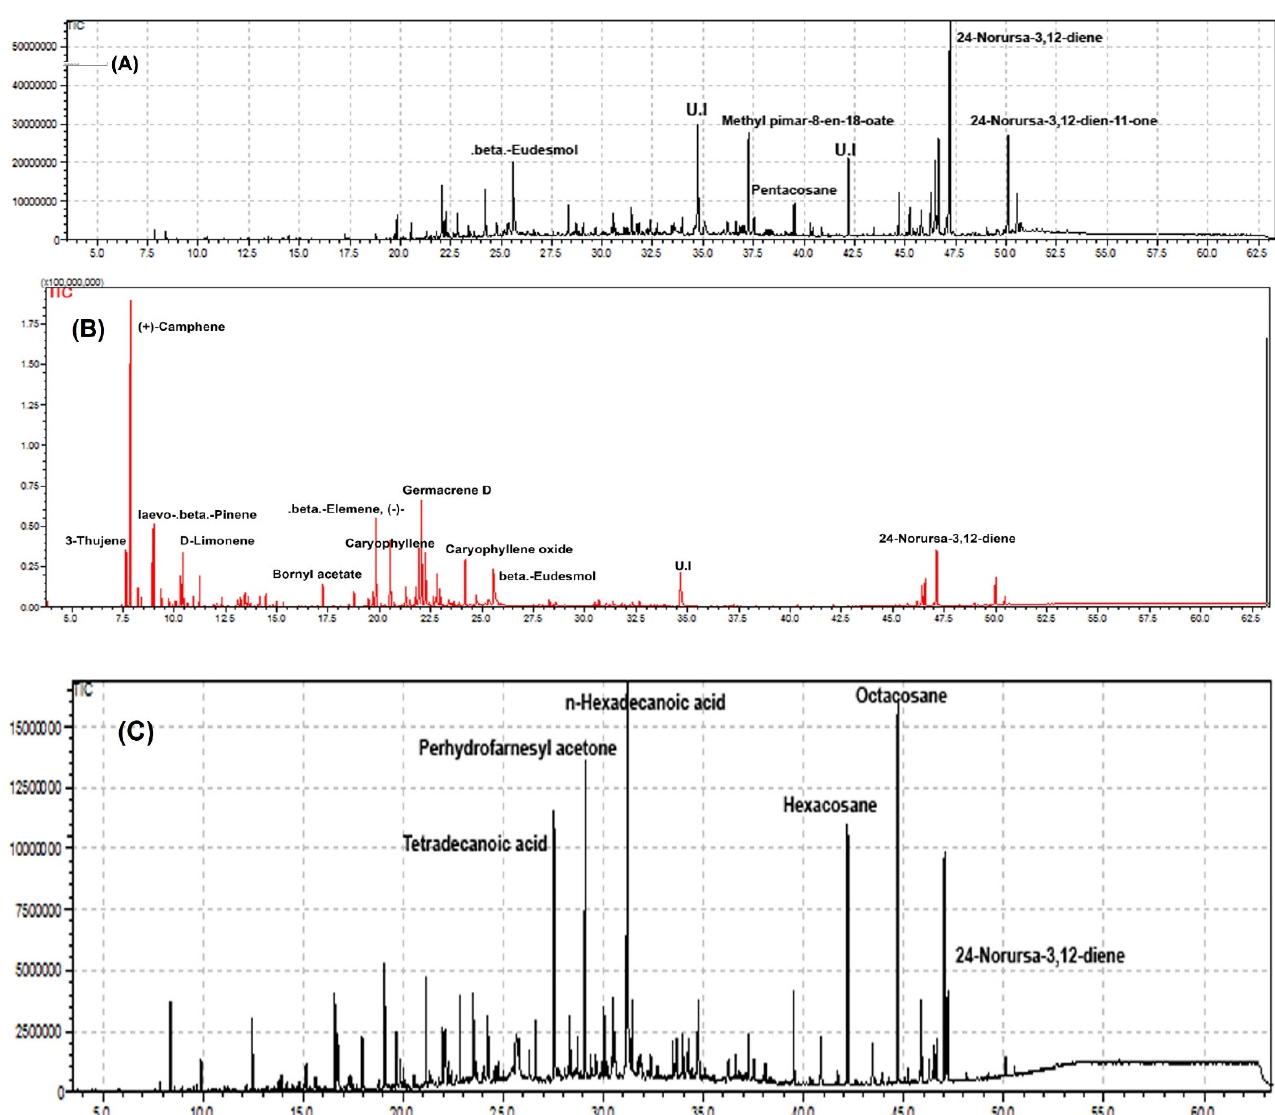
Figure 1. GC-MS chromatogram of O. arabicus essential oils: ( A ) flowers, ( B ) stems, and ( C ) leaves. The aforementioned bioactive components have significant potential to inhibit the microbial resistance to overcome microbial infections, neutralize the free radicals to prevent cellular damage, and also have promising capacities to act as an anti-cancerous agent, as shown by Hussain et al. [32] and Sonigra et al. [33]. The O. arabicus stem contains compounds such as (+)-camphene, eremophilene, δ -selinene, β -elemene, and β -eudesmol, already reported by Chandra et al. [34] in Callicarpa macrophylla and Utegenova et al. [35] in some species of the genus Ferula , who also highlight their potential against human pathogenic microbes. The EOs of the O. arabicus leaves are characterized by n -hexadecanoic acid, which was reported earlier by Ravi et al. [36], and is well known for its therapeu- tic significance. The same parts of O. arabicus also contained octaconsane, tetradecanoic acid, perhydro farnesyl acetone, and hexacosane, which have been previously reported by Swamy et al. [37] in Plectranthus amboinicus leaves, and have an antimicrobial effect. More- over, in the present study, it was revealed that all parts (flowers, stems, and leaves) have eleven common compounds, which accounted for 41.85%, 25.82%, and 12.96%,